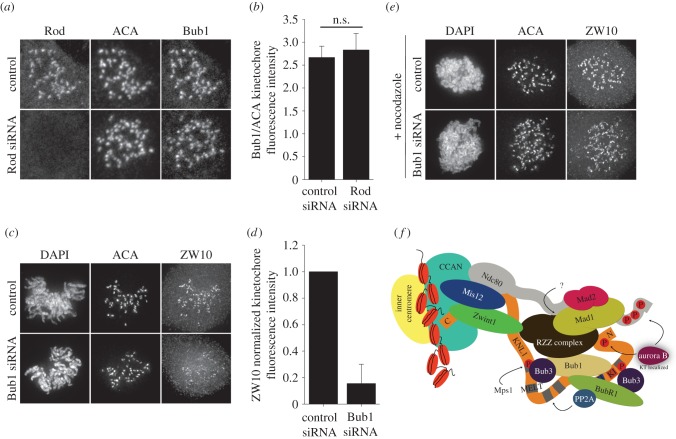
The RZZ complex requires Bub1 for proper kinetochore localization. (a–d) HeLa cells were depleted of Rod or Bub1, and immunostained for ACA and either Bub1 or the RZZ component ZW10. (b,d) Kinetochore fluorescence intensities were measured in control cells and those treated with the respective siRNAs as indicated in the bar graph. Error bars represent s.d. (b) n = 59 kinetochores, n = 3 cells per experiment, n = 2 independent experiments and n.s. = not statistically significantly different. (d) n > 192 kinetochores, n > 12 cells per experiment and n = 2 independent experiments. (e) HeLa cells depleted of Bub1 were treated with nocodazole, fixed, and immunostained for ACA and ZW10. (f) Model of Mad1/Mad2 kinetochore recruitment. KNL1-dependent recruitment of the RZZ complex to kinetochores is mediated by the KNL1 N-terminus and Bub1. Together, the RZZ complex and Bub1 mediate recruitment of Mad1 and Mad2. Whether the RZZ complex directly interacts with Mad1 is unknown. This model proposes a KNL1-independent mechanism for RZZ/Mad1 recruitment, possibly through the NDC80 complex.